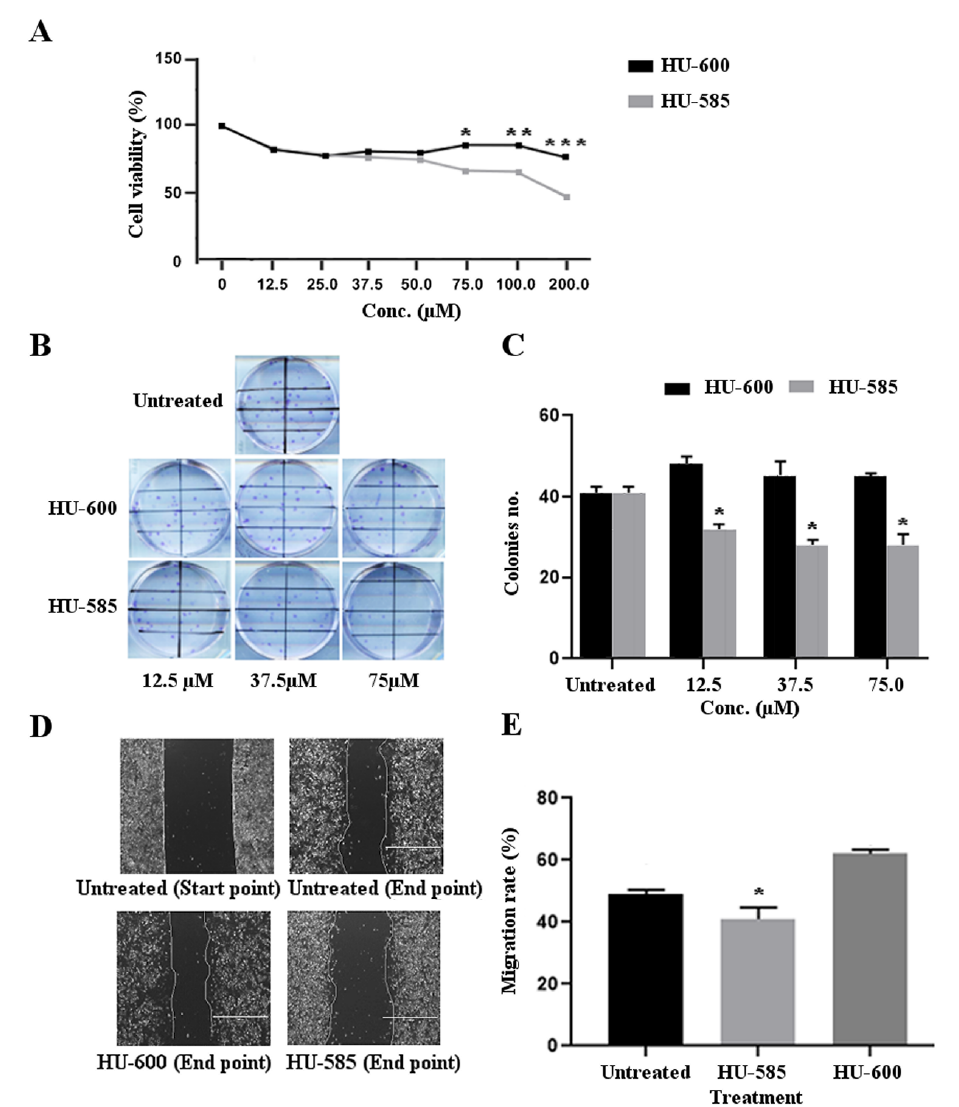
Figure 2. Anti-tumorigenic effects of HU-585 and HU-600. ( A ) Cell viability, measured with MTT assay in SK-N-SH cell line following treatment with HU-585 and HU-600. The cells were plated in 96-well plates and treated with increasing concentrations of HU-600 or HU-585 for 72 h. A significant decrease in cell viability was detected for both compounds at concentration of 12.5 µ M (16.7%, p < 0.05). A better effect in cell viability reduction was obtained for HU-585 at concentration 75 µ M and above. The cell viability reduction for HU-585 and HU-600 at 75 µ M was 33.5% and 14.4%, respectively (* p = 0.03), at 100 µ M, 34.3% and 14.7%, respectively (** p = 0.02), and at 200 µ M, 52.2% and 23.2%, respectively (*** p = 0.01). Data are expressed as percentage of the vehicle control and are the mean of pooled results from several experiments ( n = 6) performed in triplicate. Statistical significance was determined by GEE test. * p < 0.05 compared to HU-585 (1.15 < SE values < 1.99). ( B , C ) The effect of HU-585 and HU-600 on the colony formation ability of SK-N-SH cells showing a better effect of HU-585. The cells were plated in 6-well plates and treated with 12.5 µ M, 37.5 µ M and 75 µ M of HU-585 or HU-600. Cells were fixed and stained with crystal violet 14 days later. Colonies were counted using ImageJ software. ( B ) Scanned image of representative wells showing different levels of colony formation in SK-N-SH treated cells. ( C ) Representation of the quantified number of colonies in increasing concentrations of the treatment used. Statistical significance was determined by GEE test, * p < 0.05 ( n = 3, performed in duplicates). ( D , E ) Migration rate of SK-N-SH cells